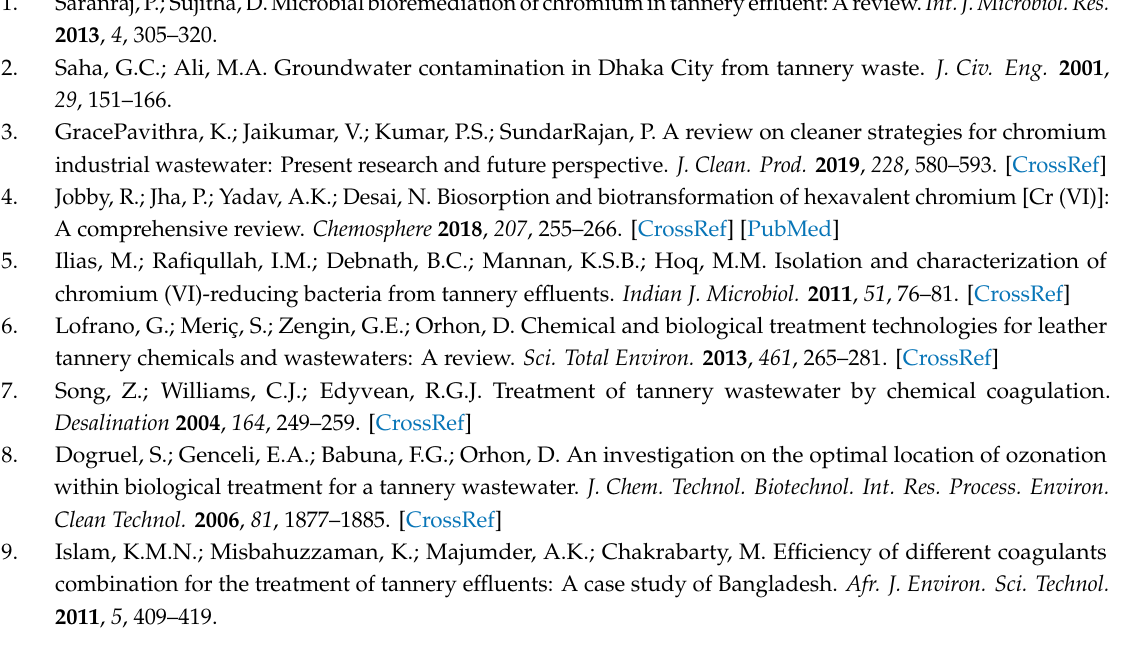
Figure S1: Locations from where the 14 samples were collected, Figure S2: Reduction of Cr(VI) by the isolate SH-1 in Minimal salt broth with an initial concentration of 100 mg / L after 24 h and 48 h of incubation at 37 ◦ C, Figure S3: Pseudo-first order kinetics plots for biosorption of Cr(VI) by live and dead bacterial biomass, Figure S4: The EDX analysis of biomass of Klebsiella sp. (SH-1). (a) EDX of controlled biomass and (b) chromium treated biomass, Table S1: Analysis of Physicochemical properties of Tannery e ffl uents, Table S2: Bangladesh national standards—waste discharge quality standards for industrial units and projects: quality at discharge point, Table S3: Morphological characteristics of Cr (VI) resistant isolates from tannery e ffl uents, Table S4: Antibiotics sensitivity of SH-1, Table S5: Pseudo-first order kinetics constants for biosorption of Cr(VI) by live and dead bacterial biomass. Author Contributions: Conceptualization: S.H. (Shanewaz Hossan) and S.H. (Saddam Hossain); methodology: S.H. (Shanewaz Hossan) and S.H. (Saddam Hossain); formal analysis: S.H. (Shanewaz Hossan) and